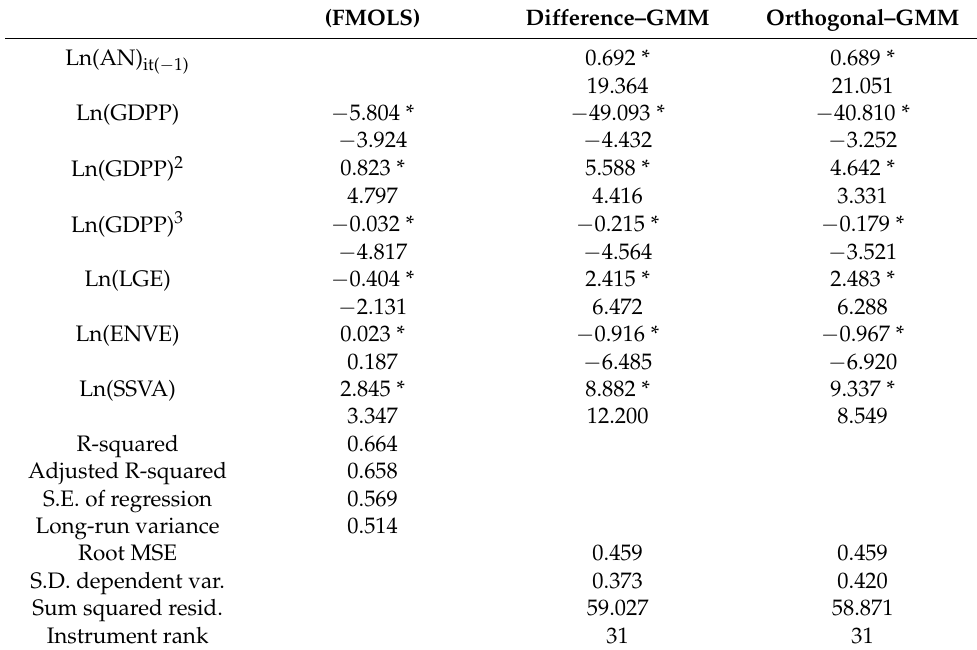
Table 6. Results for the second-stage estimation using ammonia nitrogen emissions (AN) as the dependent